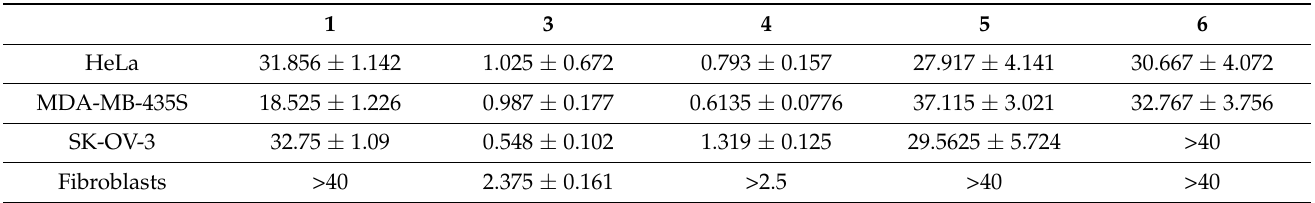
Table 4. The cytotoxic activity of analyzed compounds a towards HeLa, MDA-MB-435S, SK-OV-3 cells and fibroblasts. IC 50 (IC 50 / µ M ± SD) values were calculated upon 72 h of incubation with the compounds. The cytotoxicity was measured by MTT